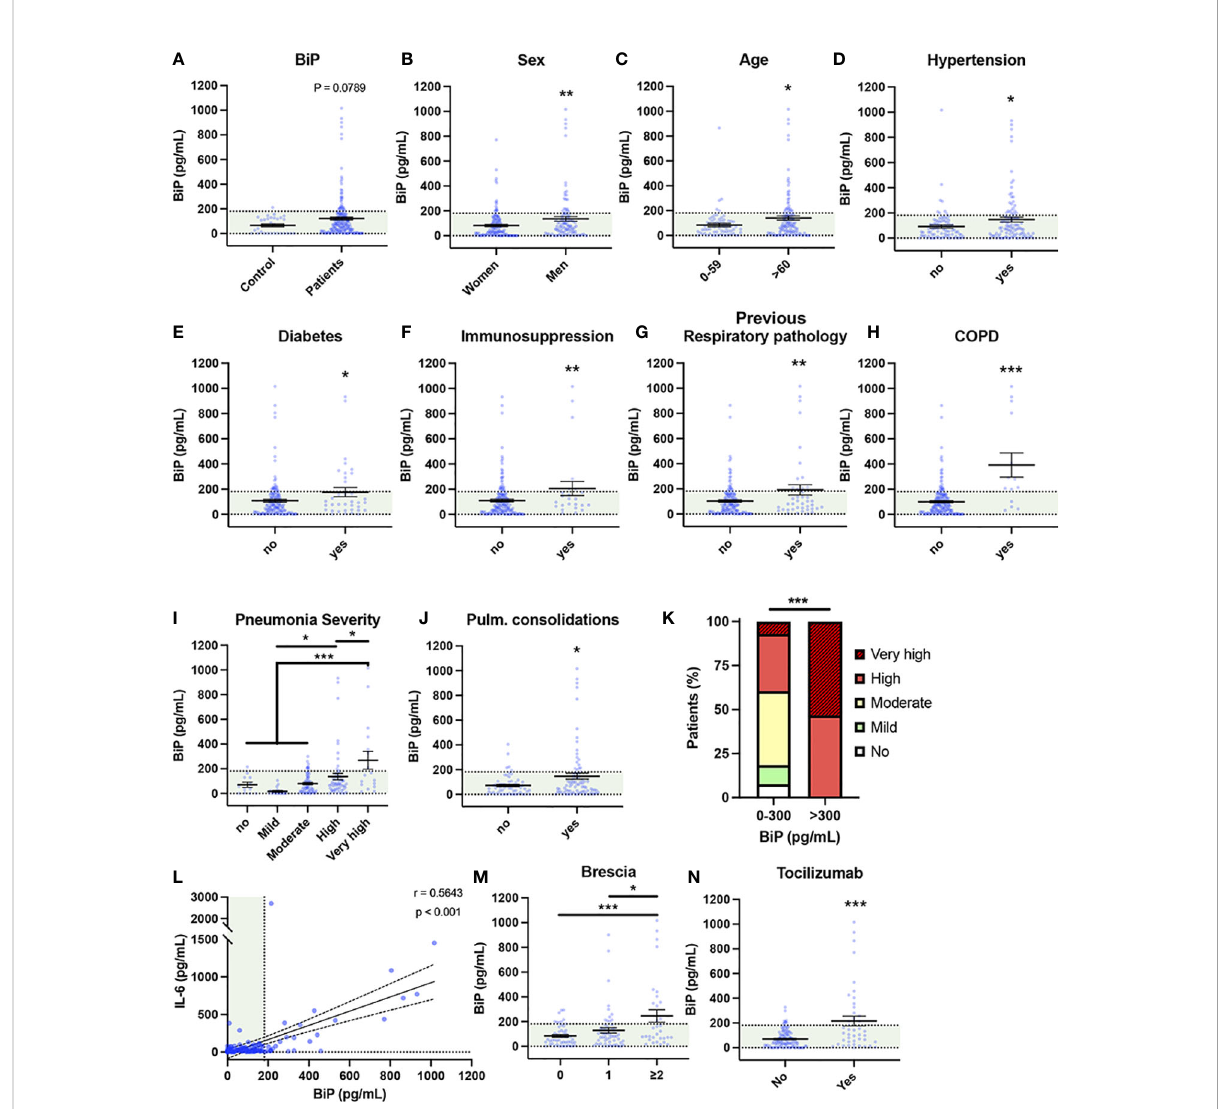
FIGURE 1 Serum BiP levels are increased in certain groups of COVID-19 patients. (A – L) Serum BiP levels classi fi ed by group of patients/donors. Black lines and whiskers denote the mean ± SEM of every data set. Green areas represent normal BiP levels in serum (0 and 181 pg/mL, respectively) de fi ned between 5 th and 95 th percentiles of healthy donor ’ s data set. General BiP levels in total cohort: healthy control patients (n=30) versus COVID-19 patients (n=194) (A) ; BiP levels classi fi ed by Sex (B) , Age (C) , and previous comorbidities (D – H) . (I) Serum BiP in patients classi fi ed by pneumonia severity in 5 levels depending on oxygen saturation, Tachypnea and need for mechanic ventilation. (J) BiP levels analyzed by radiological presence of pneumonia pulmonary consolidations developed during COVID-19. (K) Stacked bar plot showing percentage of patients with BiP levels below or above the selected critical threshold (300 pg/mL) who developed severe pneumonia (denoted by color code in legend). (L) Scatter plot showing a positive correlation between BiP levels versus IL-6 levels in blood serum tested by Pearson ’ s correlation coef fi cient. (M) BiP levels analyzed by Brescia-COVID Respiratory Severity Scale. (N) BiP levels analyzed by application of Tozilizumab treatment. * P < 0.05, ** P < 0.01, *** P < 0.001 indicate statistical signi fi cant differences between indicated samples for a Two-Tailed unpaired t-Test (A – H, J, N) , One-Way ANOVA with a Tukey ’ s multiple comparisons test (I, M) and Chi-square test (K)